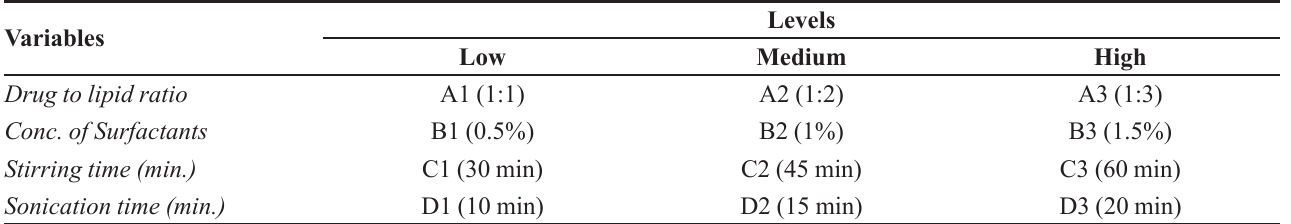
TABLE VII - Showing codes for all variables at three different level Variables Drug to lipid